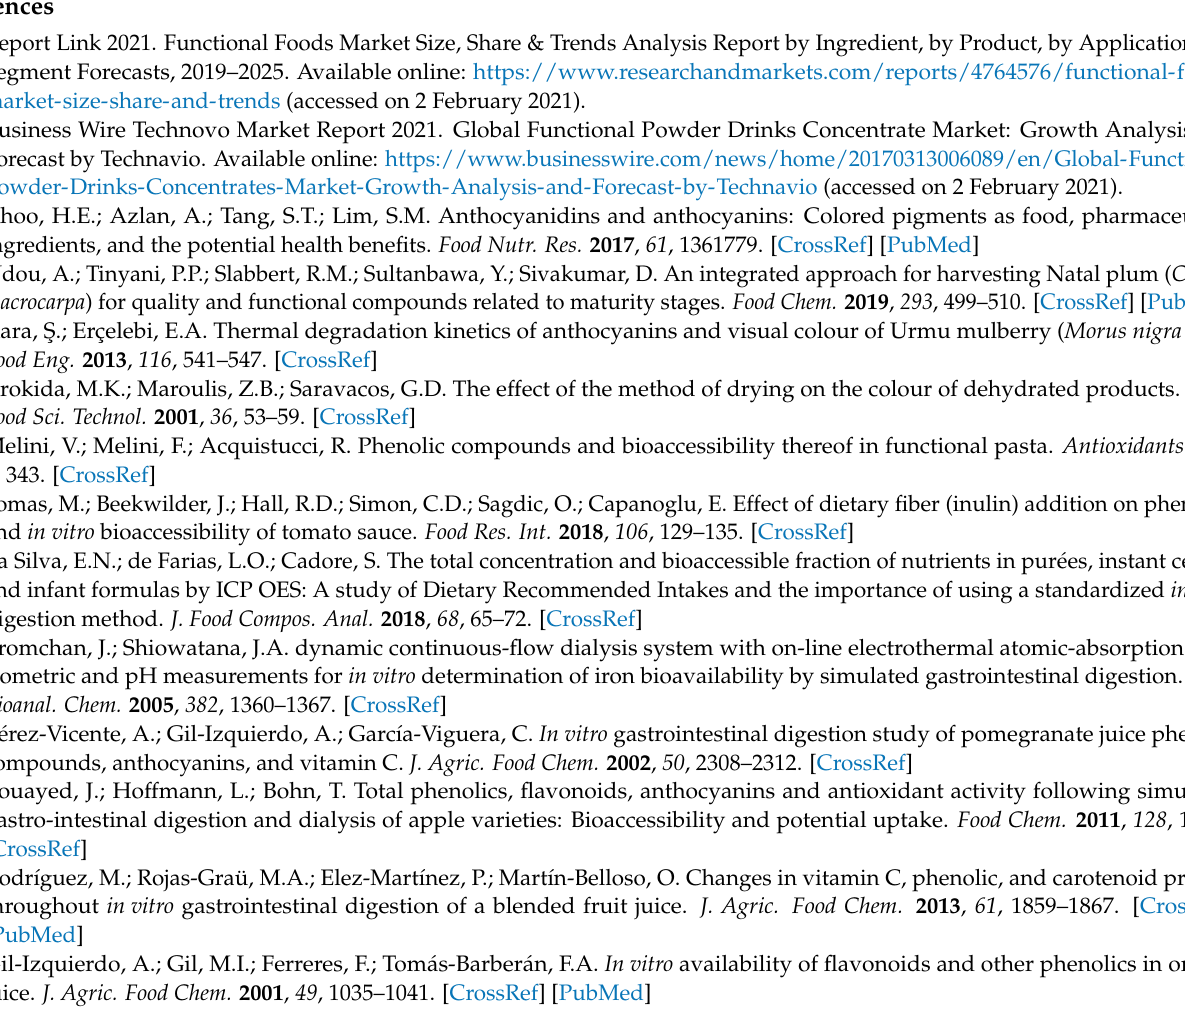
pattern; Table S1 Phenolic identification and quantification using HPLC-DAD; Table S2. Tentative peak identification of the compounds detected in the hydromethanol extract of undigested, gastric and intestinal digested Natal plum freeze dried powder; Table S3. Pearson’s correlation coefficient of different phenolic components antioxidant and α -glucosidase